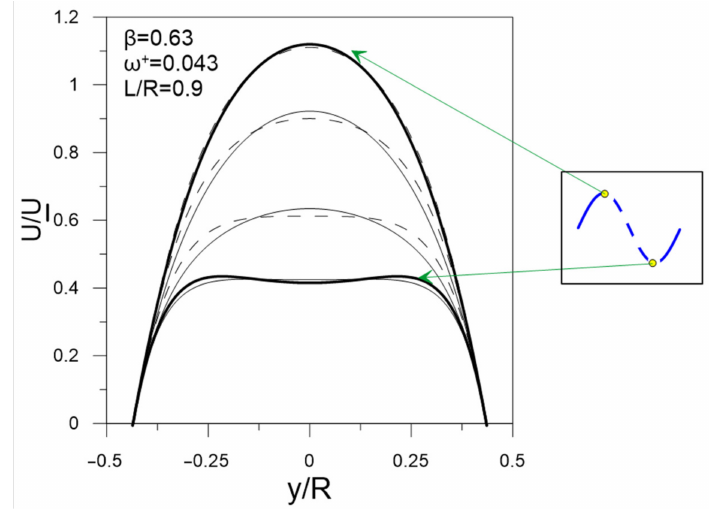
Figure 9. Dynamics of velocity profile on chord near the wall.